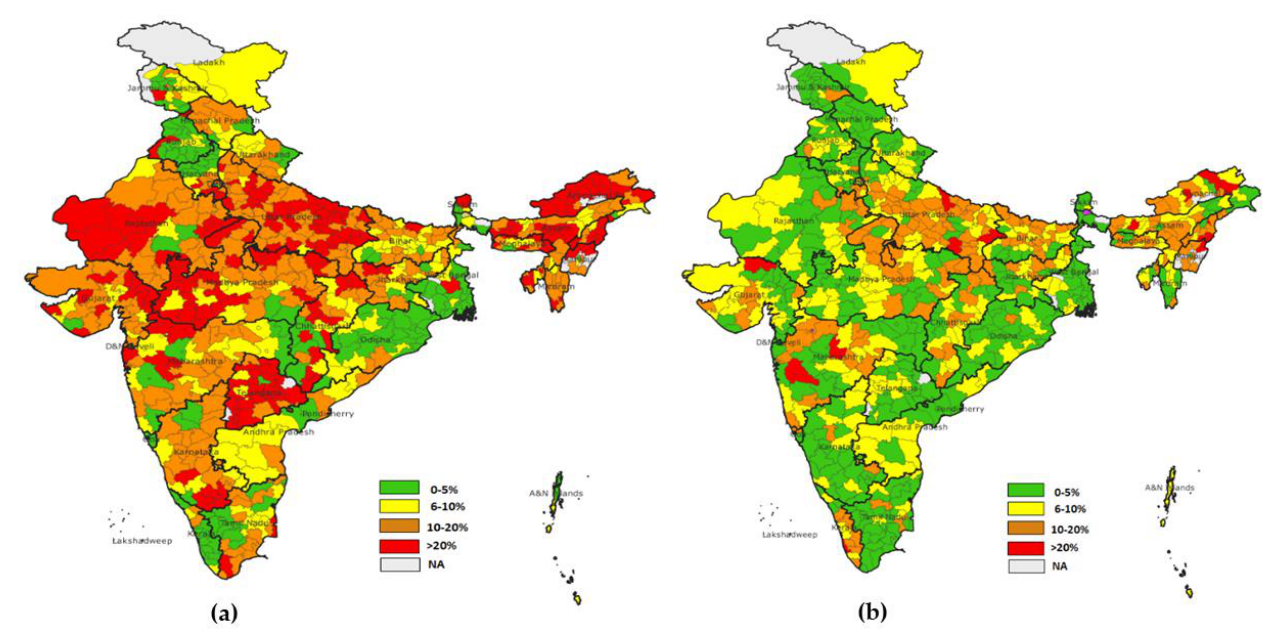
Figure 8. ( a ) District level dropout rate for DPT1-DPT3 (NFHS-4), ( b ) district level dropout rate for DPT1-DPT3 (NFHS-5).